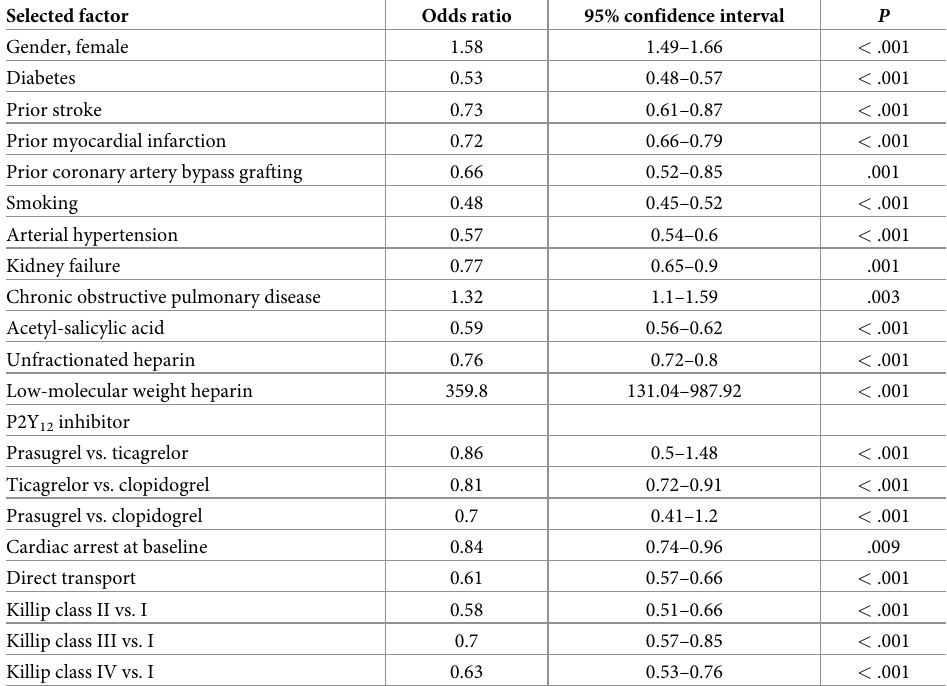
Table 4. Predictors of MINOCA vs. MI-CAD in patients admitted due to STEMI–univariate analysis. Selected factor Odds ratio